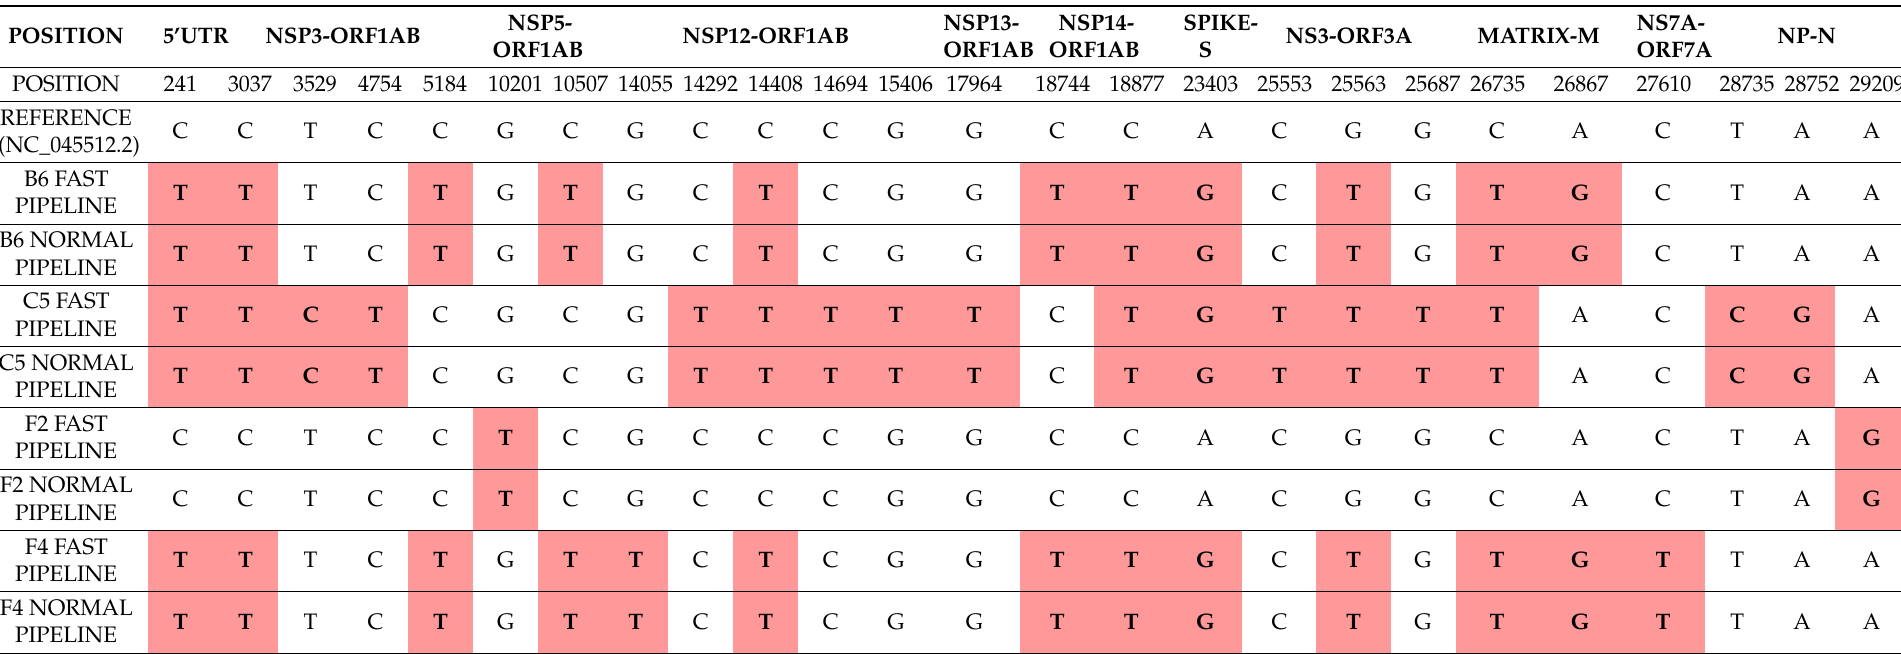
Table 8. Identified SNPs in All Batch 1 Samples Running All